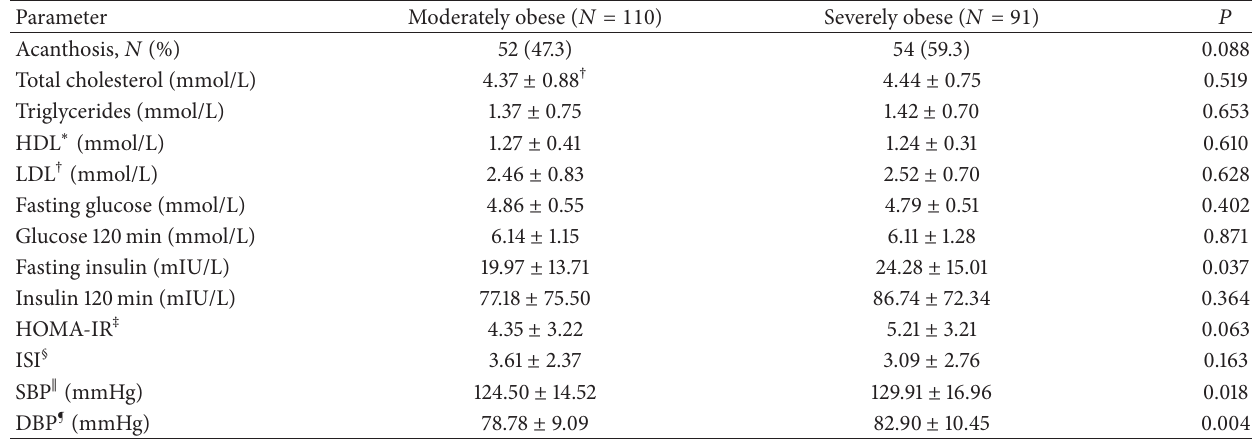
Table 2: Biochemical and clinical characteristics of subjects enrolled in the